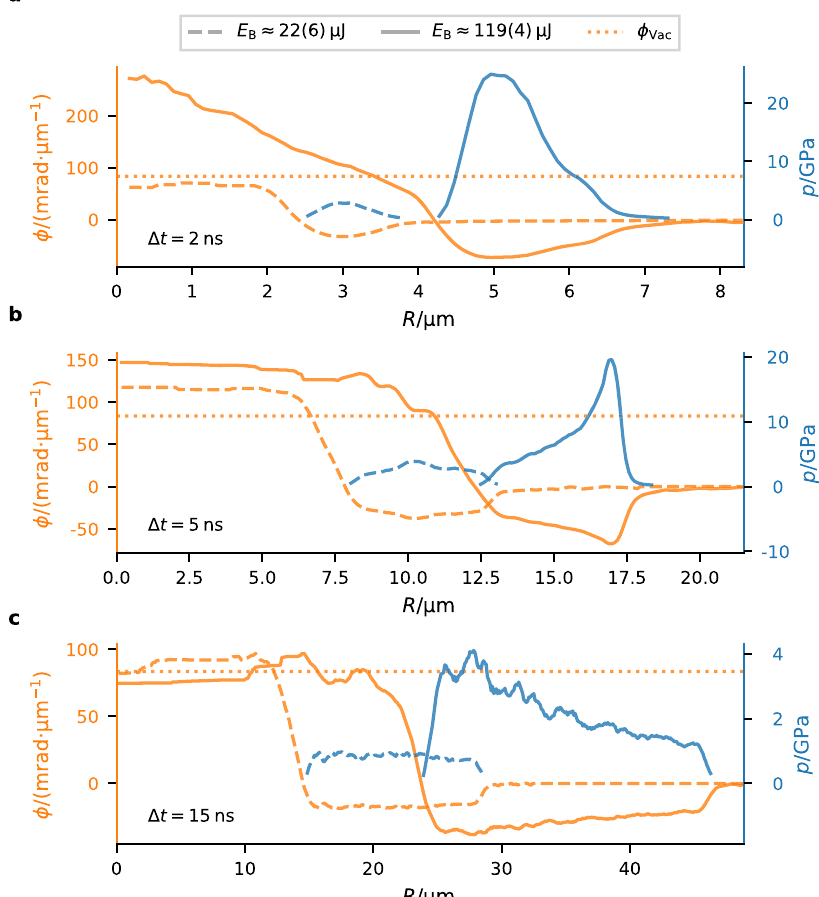
Fig. 3 Phase and pressure distributions of individual bubbles. a – c Radial phase ϕ ( R ) and spatial shockwave pressure p ( R ) for Δ t = 2 ns, 5 ns and 15 ns, respectively. For each delay two exemplary cavitation events with energy of E B ≈ 22(6) μ J (dashed) and 119(4) μ J (solid) are compared. The 3d-phase distribution ϕ ( R ) is shown on the left ordinate (orange), the pressure distribution of the shockwave p ( R ) on the right ordinate (blue). The phase shift of vacuum to water ϕ vac (dotted) is shown for comparison. A phase pro fi le exceeding this line (as is typically the case for small Δ τ and high E B ) indicates a non-spherical bubble, and hence the necessity to introduce the ellipticity factor ϵ (see text). The pressure distribution of the shockwave was calculated using the Tait